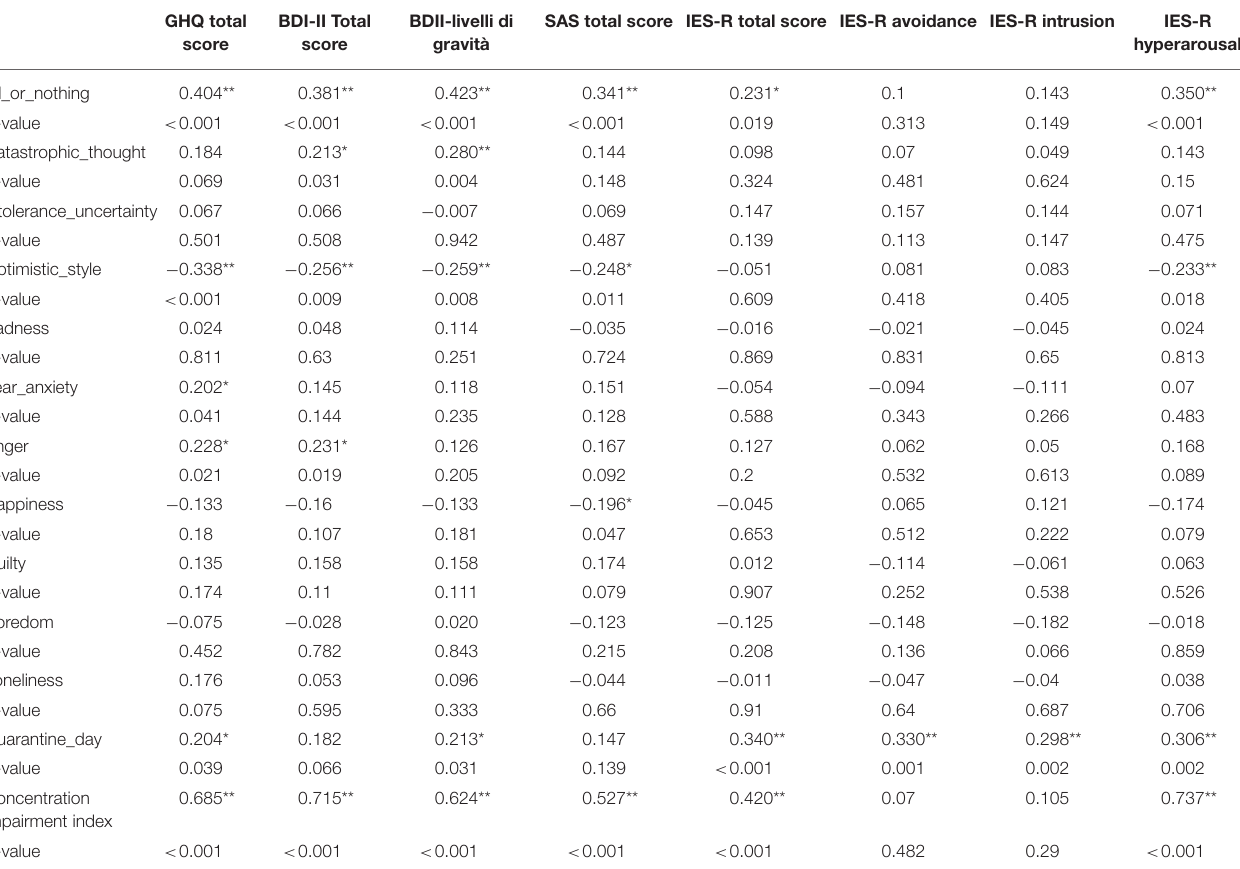
TABLE 5 | Correlation analyses and qualitative and quantitative measures. GHQ total